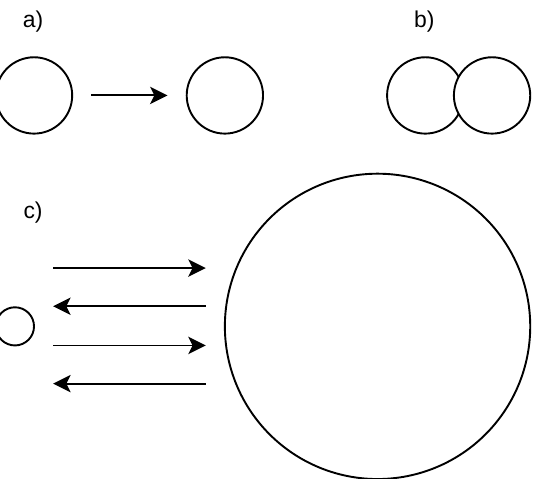
Figure 9. Confidence areas related to indication events: ( a ) border to border distance, ( b ) risk score is zero, and ( c ) multiple indication events and use of a larger